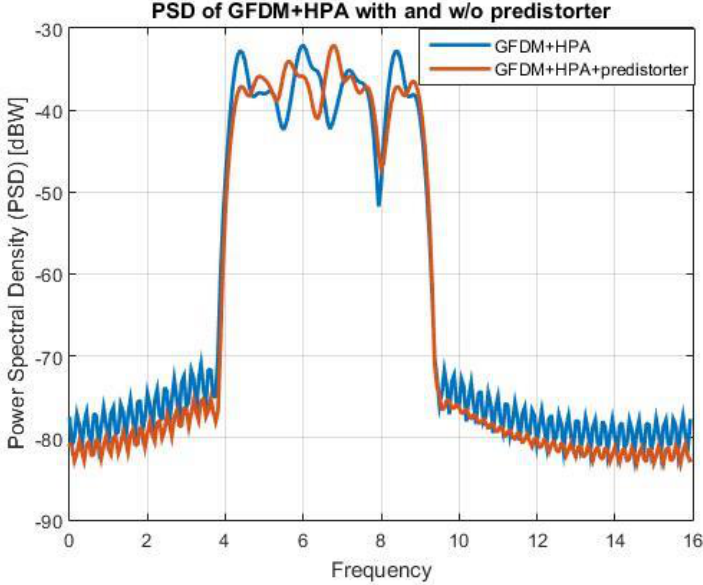
Figure 7. PSD SISO GFDM + HPA with and without predistorter.